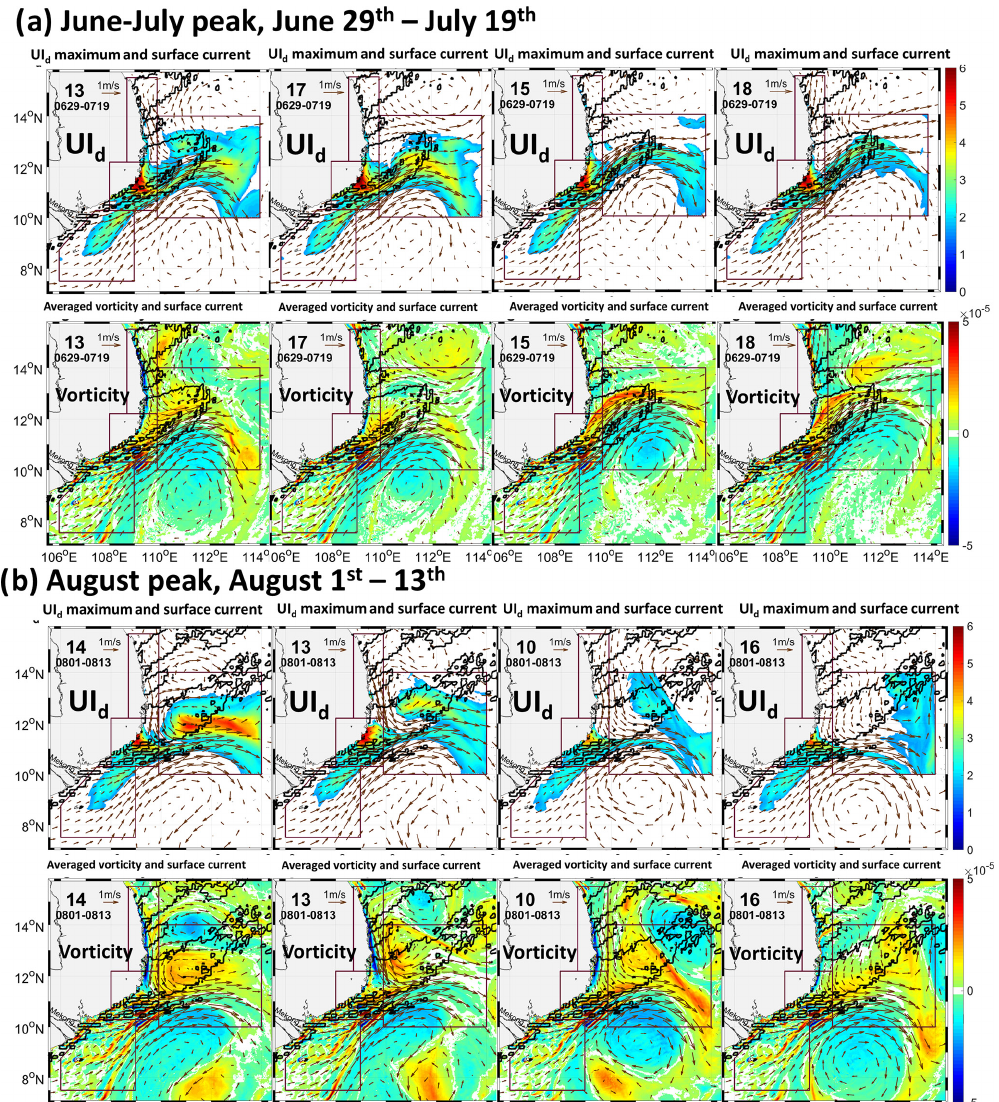
Figure 4. Maps of UI d (top, ◦ C) on the day of maximum UI d , boxOF over the periods of OFU development (highlighted in blue in Fig. 2) in (a) July and (b) August, and of average surface current vorticity (bottom, s − 1 ) during each period for two members of strong OFU (members 13 and 17 for July, members 14 and 13 for August, Fig. 2a) and two members of weak OFU (members 15 and 18 for July, members 10 and 16 for August). Black contours: 3.10 − 7 Nm − 3 iso-contours of average wind stress curl during each period. Arrows: average surface current (ms − 1